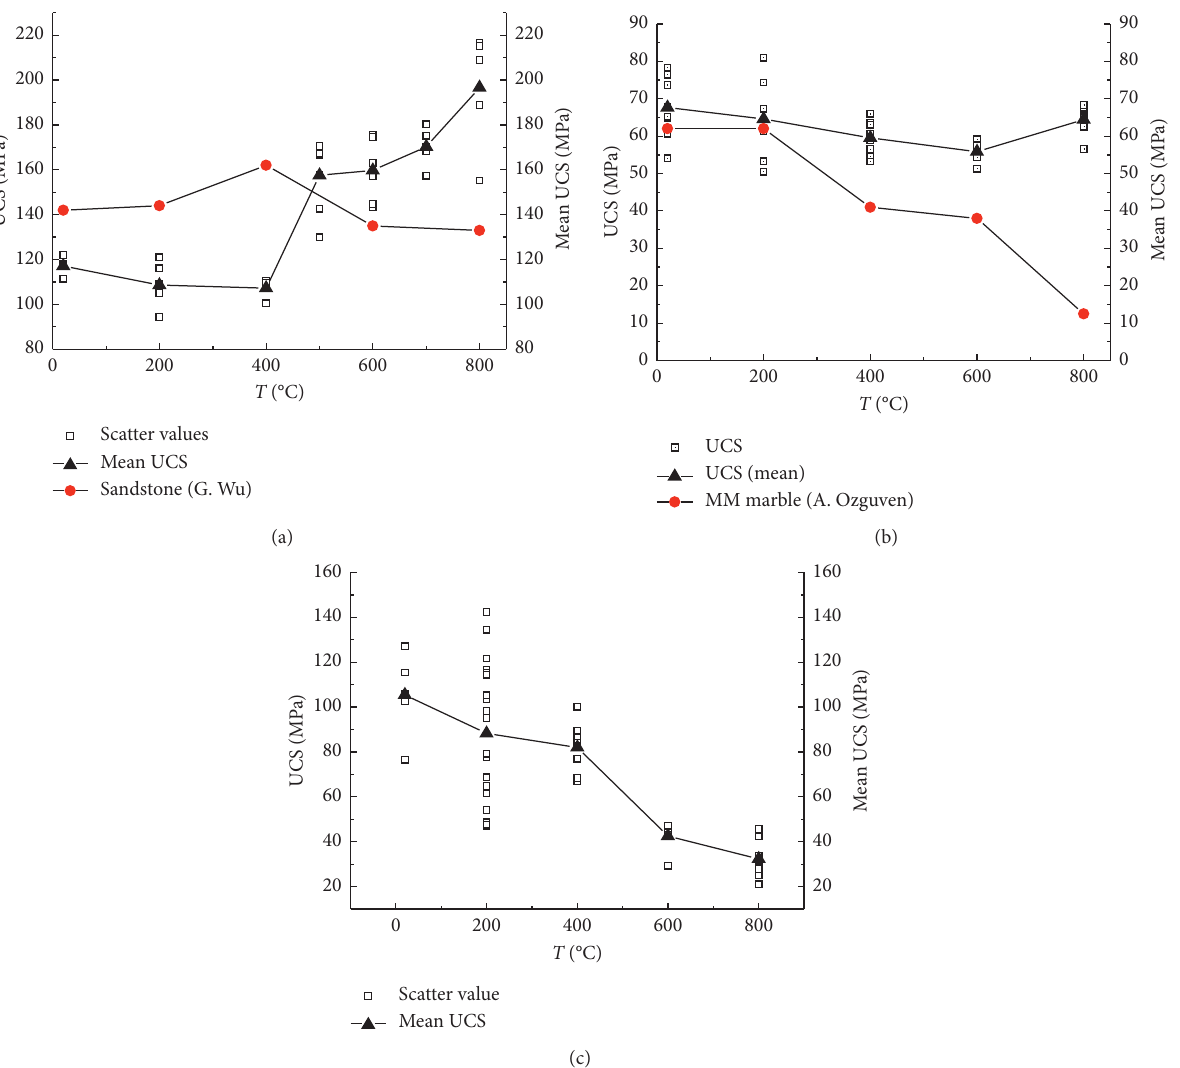
Figure 3: Variation of rock uniaxial compressive strength with temperature: (a) sandstone samples, (b) marble samples, and (c) granite